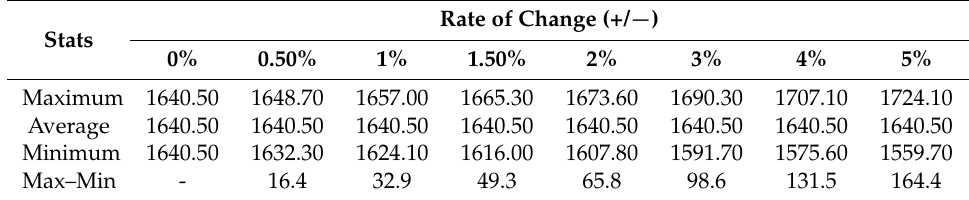
Table 3. Sensitivity analysis of maximum and minimum emission levels during the first phase in millions of tons (The average increase over the last 10 years was 1.7% in Korea (Trends in Global CO 2 emissions: 2016 report) and, based on 2015 emission levels, the average rate required for reducing carbon emissions